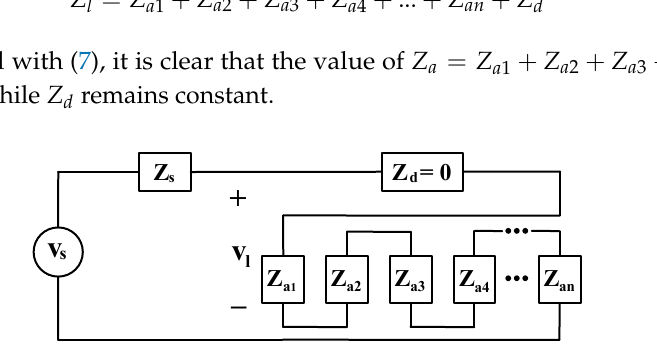
Figure 5. Effect of increasing the size on load side